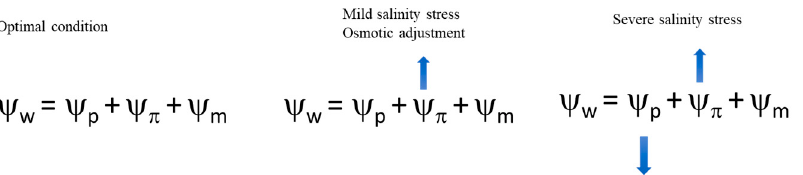
Figure 1. Water balance of crops under normal conditions and under progressive stress conditions (from left to right). The increase in salinity stress induces the accumulation of osmolytes that increase the ability of root cells to uptake water (the cell osmotic potential becomes more negative). The progression of salinity and its severity cannot be counteracted with only osmolytes; the plant does not uptake water and loses its turgor. Ψ W = water potential; Ψ p = pressure potential; Ψ π = gravimetric potential; and Ψ m = matric adsorption force .